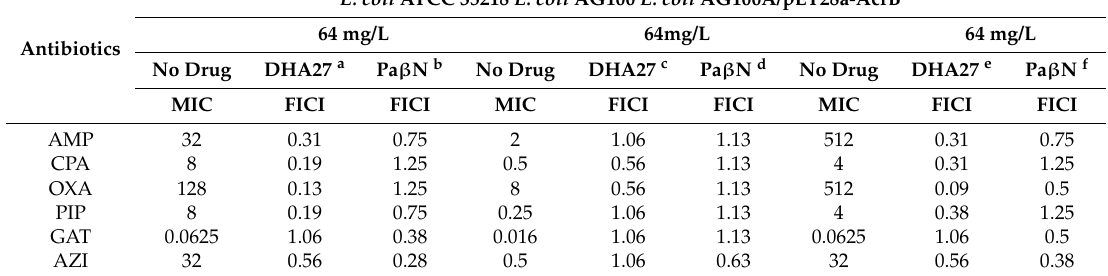
Table 4. Effect of DHA27 and PA β N in combination with different antibiotics on antibacterial activity against three E. coli